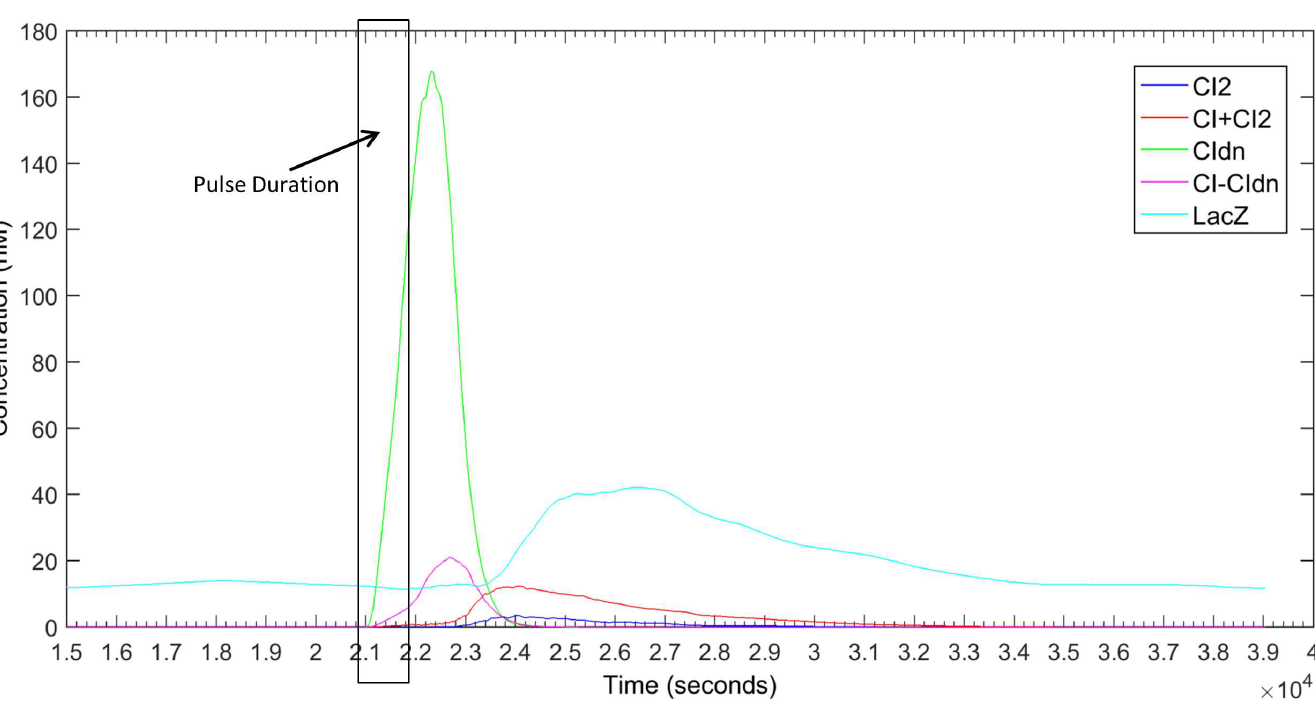
Fig 2. Response of the pulse detector circuit in Fig 1 for a pulse duration of ½ bacterial cell-cycle (CC) [1020 sec]. The pulse was activated at 10.2 CC (20808sec) and deactivatedat 10.7 CC (21828sec). The relative strength of RBS1 and RBS2 was 20:1 and the degradationtag had half-life of 4 minutes. The responseis averageof 20